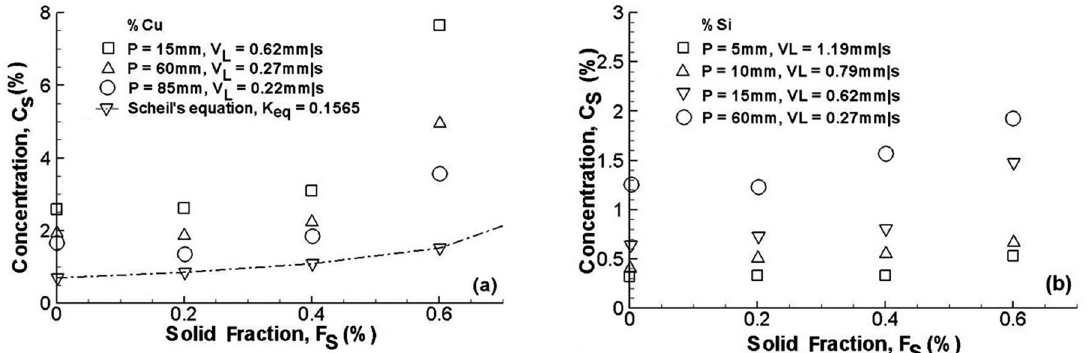
Figure 7. Microsegregation of solutes in the ternary Al-9.0wt%Si-4.0wt%Cu alloy: (a) Cu and (b) Si.